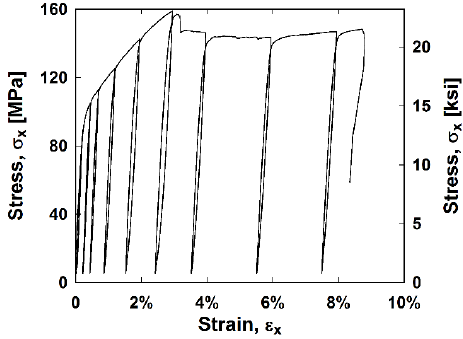
Figure 3. Average stainless steel composite stress – strain curves.